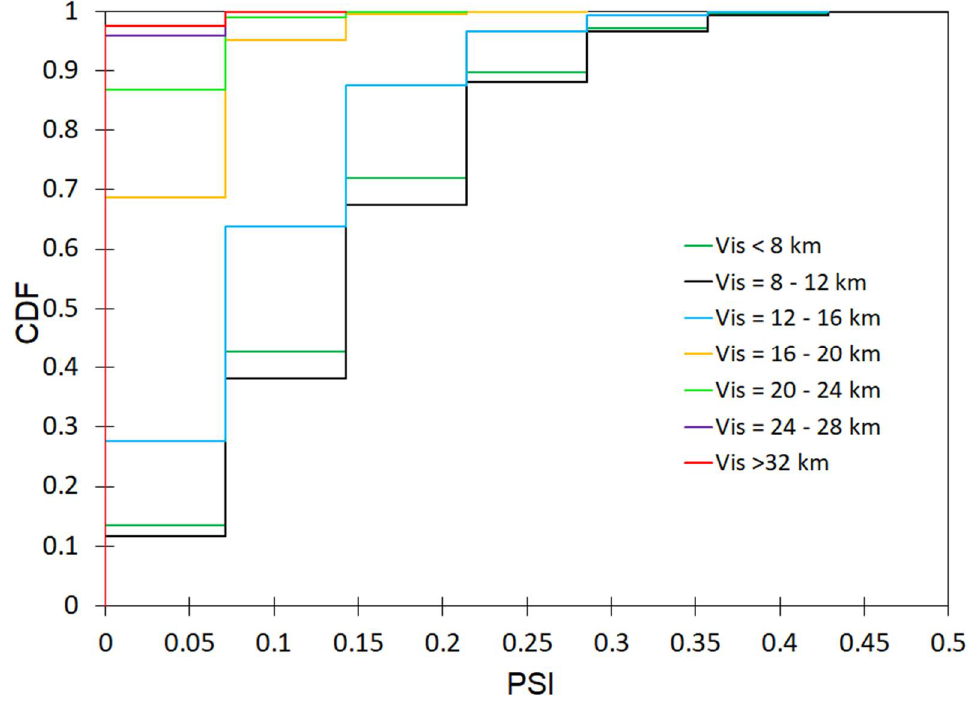
Figure A25. Effect of visibility on the incidence of mean winter mortality for dry days.